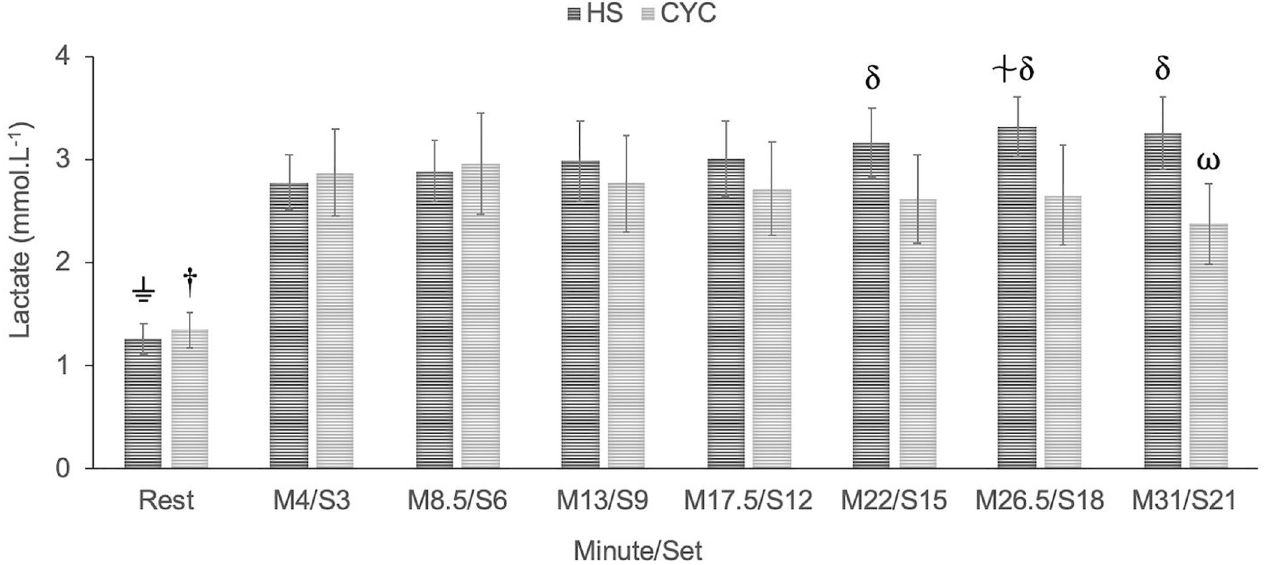
Fig 2. Multiple comparisons between cycle ergometer (CYC) and half-squat (HS) in blood lactate. ⏚ Significantly different from S3, S6, S9, S12, S15, S18, S21 in HS exercise, p < 0.001. † Significantly different from M4, M8.5, M13, M17.5, M22, M26.5, M31 in cycle ergometer, p < 0.01. δ Significantly different from cycle ergometer in M22/S15, M26.5/S18, M31/S21, p < 0.05. ⍵ Significantly different from M4 in cycle ergometer, p = 0.028. ⏆ Significantly different from S3 and S6 in HS exercise, p < 0.05.